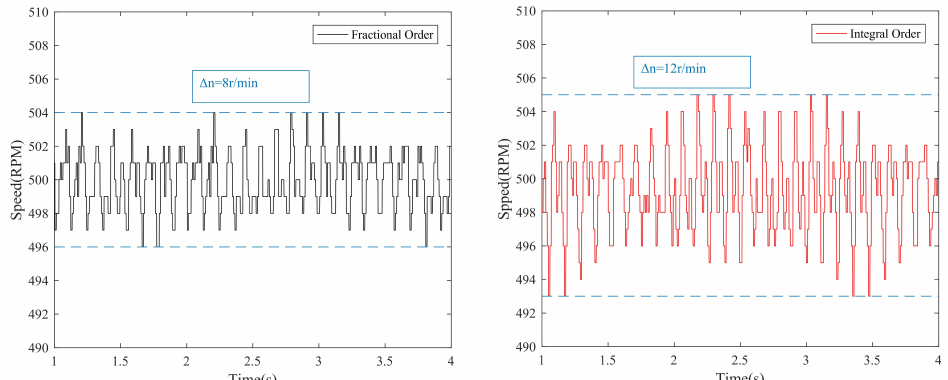
Figure 9. The speed fluctuation of motor at middle